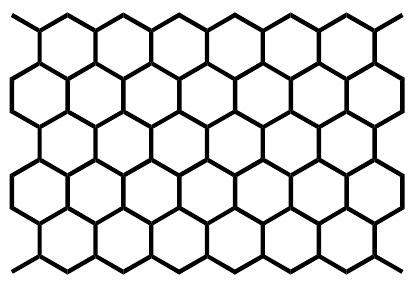
Fig. 2. The 2-Dimensional Lattice of TUZC